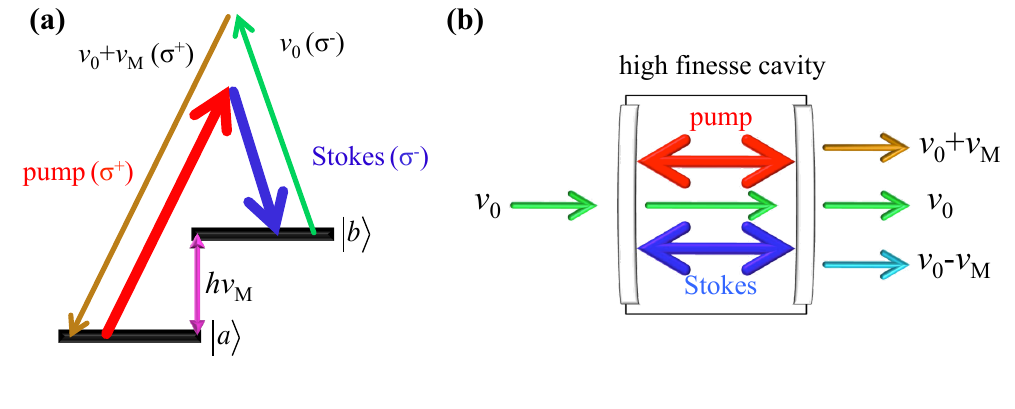
Figure 1. ( a ) Simplified energy level diagram. Two intense lasers, the pump and the Stokes, drive the Raman transition and establish the molecular coherence, ρ then be used to modulate any other mixing laser with frequency ν upshifted or downshifted sidebands at frequencies ν the polarization configuration as shown, only a frequency upshifted sideband is produced. ( b ) Molecular modulation with CW laser beams. The molecules are placed inside a cavity with a high finesse at the pump and at the Stokes wavelengths. For a sufficiently large molecular coherence, any mixing laser incident on the cavity will be modulated. The mixing beam does not need to be resonant with the cavity as the modulation is produced in a single pass through the